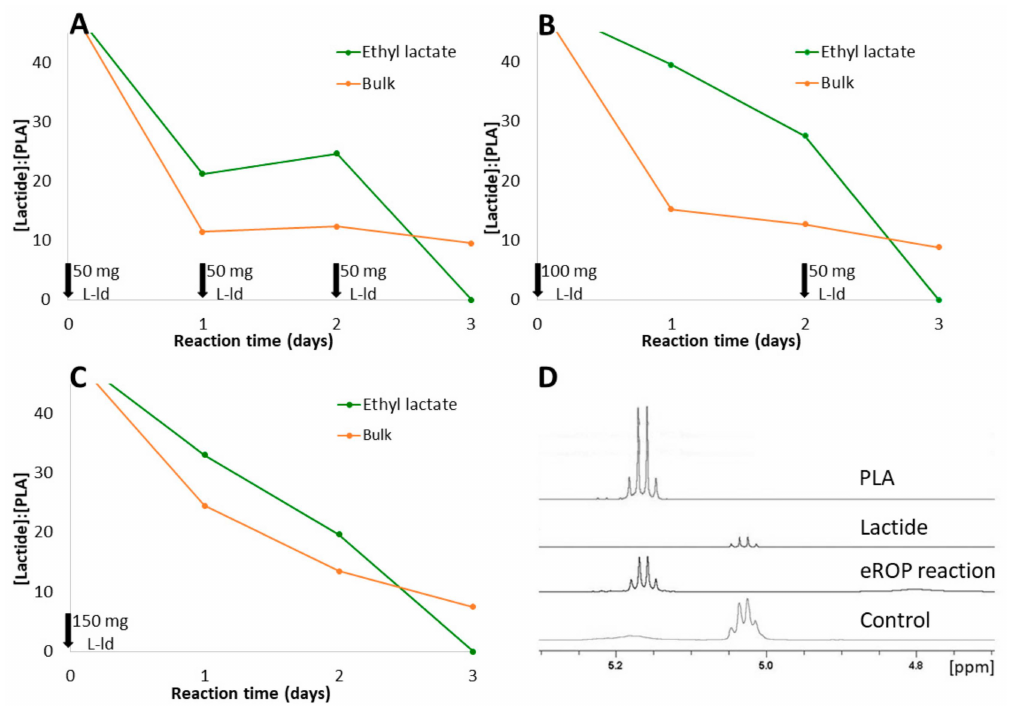
Figure 8. Synthesis of L -PLA via eROP catalyzed by OPEr at 100 ◦ C and 800 rpm. Aliquots of eROP reactions were taken every 24 h and analyzed by 1 H-NMR. The signals at 5.0 ppm from lactide and at 5.2 ppm from PLA were integrated to calculate the ratios of their areas. Black arrows indicate addition of L -lactide (L-ld) in 3 pulses of 50 mg of lactide every 24 h ( A ); in 2 pulses, one of 100 mg at the start of the reaction and a second one of 50 mg at 48 h of reaction ( B ); or in a single pulse of 150 mg at the beginning of the reaction ( C ). Region between 5.3–4.7 ppm of the 1 H-NMR spectra of commercial PLA, lactide, an eROP reaction (procedure B in ethyl lactate, t = 3 days) and a control without enzyme ( D